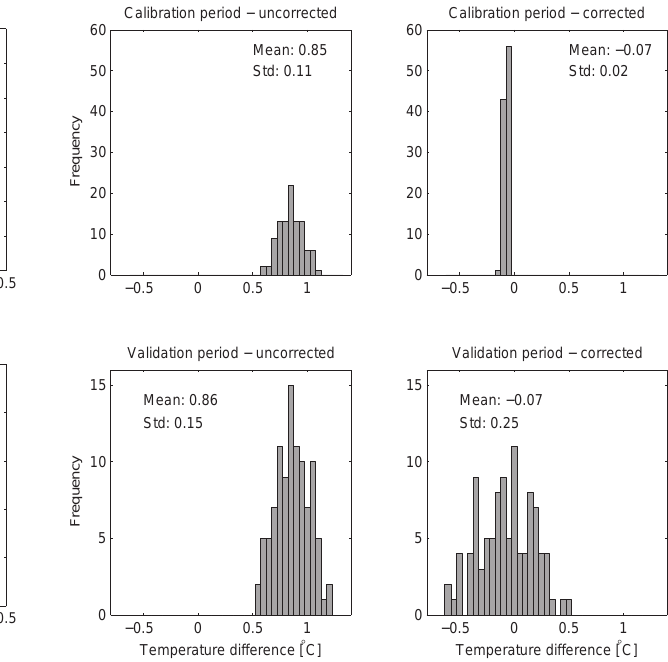
Fig. 18. Top: histograms of 100 samples of average daily precipi- tation differences between the uncorrected and observed (left), and between the corrected and observed precipitation (right) for the cal- ibration period. Bottom: similar, but for the validation period.